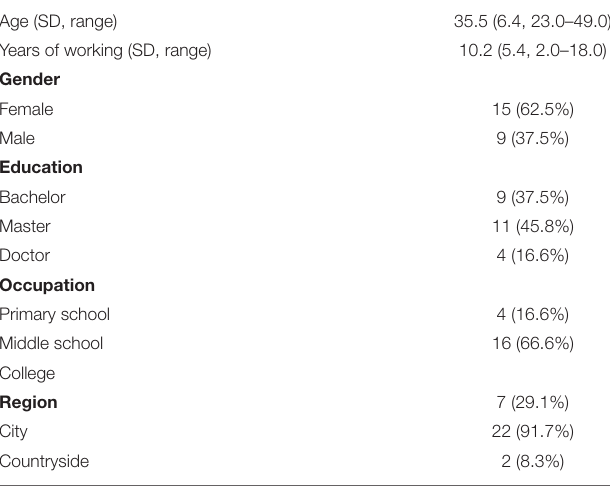
TABLE 1 | Participant